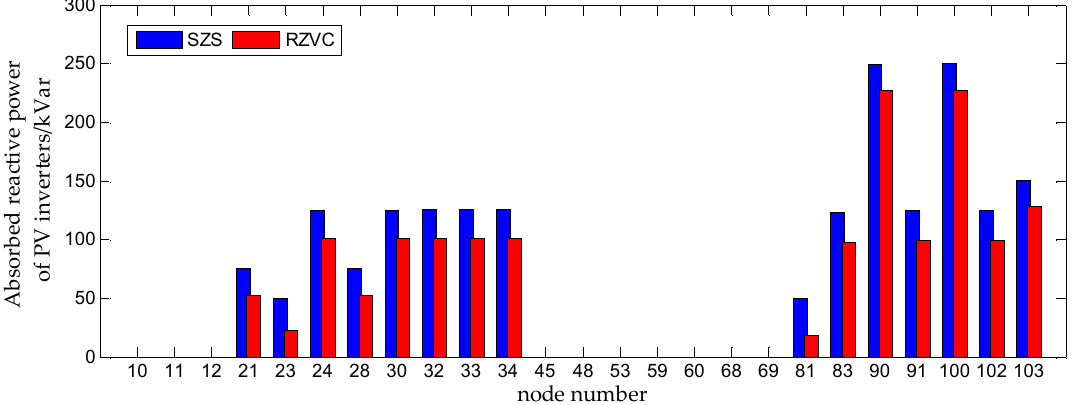
Figure 9. Absorbed reactive power of PV inverters under SZS and RZVC.